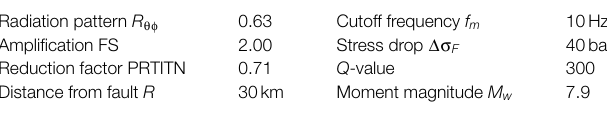
FIGURE 6 | Assumed fault plane and hypocenter in Tokyo area together with observed site. TABLE 2 | Fault parameters of Great Kanto earthquake in 1923.